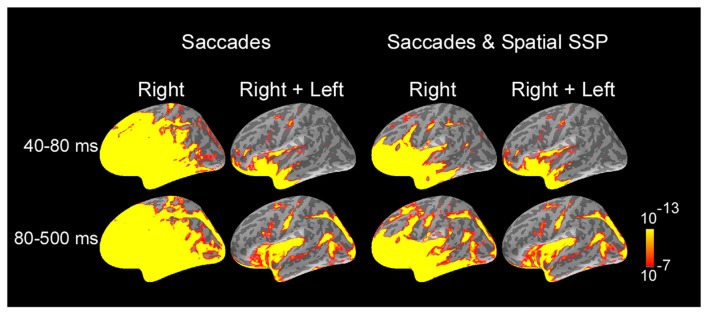
Average dynamic statistical parametric maps (dSPMs) across subjects and selected response windows following saccade onset, computed separately for right saccades and for the average of right and left saccades. For right saccades, activity at 60 ms was dominated by saccadic ocular artifacts. Ocular artifacts were greatly reduced for MEG data filtered with SSP. Estimates of the average of right and left saccades showed the largest signal-to-noise ratio and no contamination with ocular artifacts across most of cortical surface and were further analyzed to examine cortical activity following the onset of saccades. Average dSPMs are displayed on the inflated hemispheres of the average brain of all subjects (N = 7). Significance is indicated with color bars.